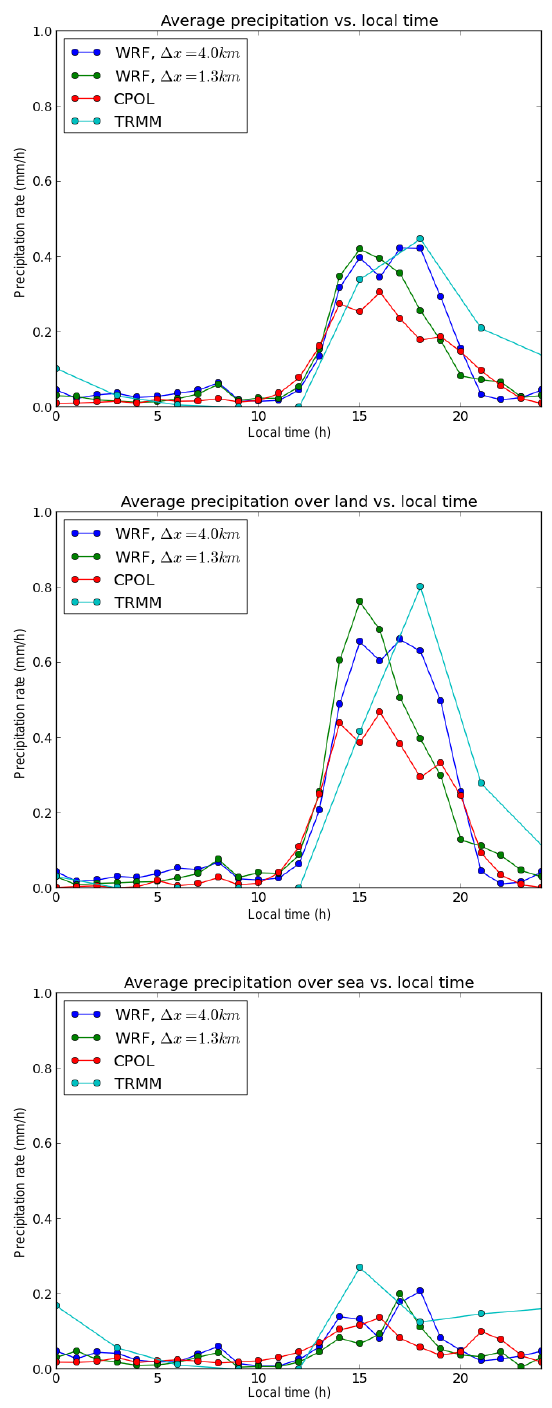
Figure 3. Comparison of simulated diurnal rainfall at 4 and 1.33km resolutions with TRMM and radar-derived precipitation (CPOL) around Darwin, Australia, area averaged over the entire horizon- tal coverage (top), over land (middle), and over sea points (bot- tom) within the radar domain respectively. The mean diurnal cycle is composited using days 2–9 and 11–12